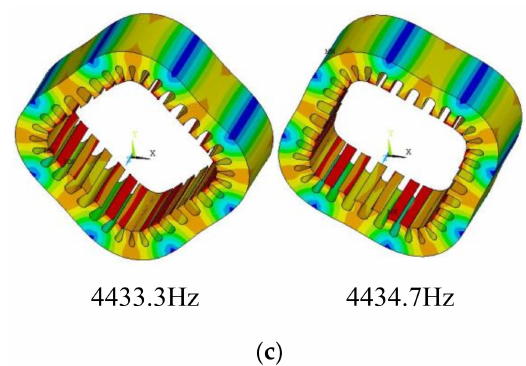
Figure 8. Radial modal shapes of stator. ( a ) The second modal shape; ( b ) The third modal shape; ( c ) The fourth modal shape.